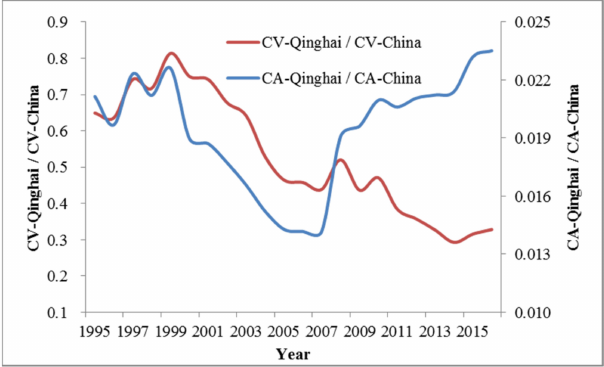
Figure 8. Change in ratio of carbon intensity in Qinghai province to that in China over